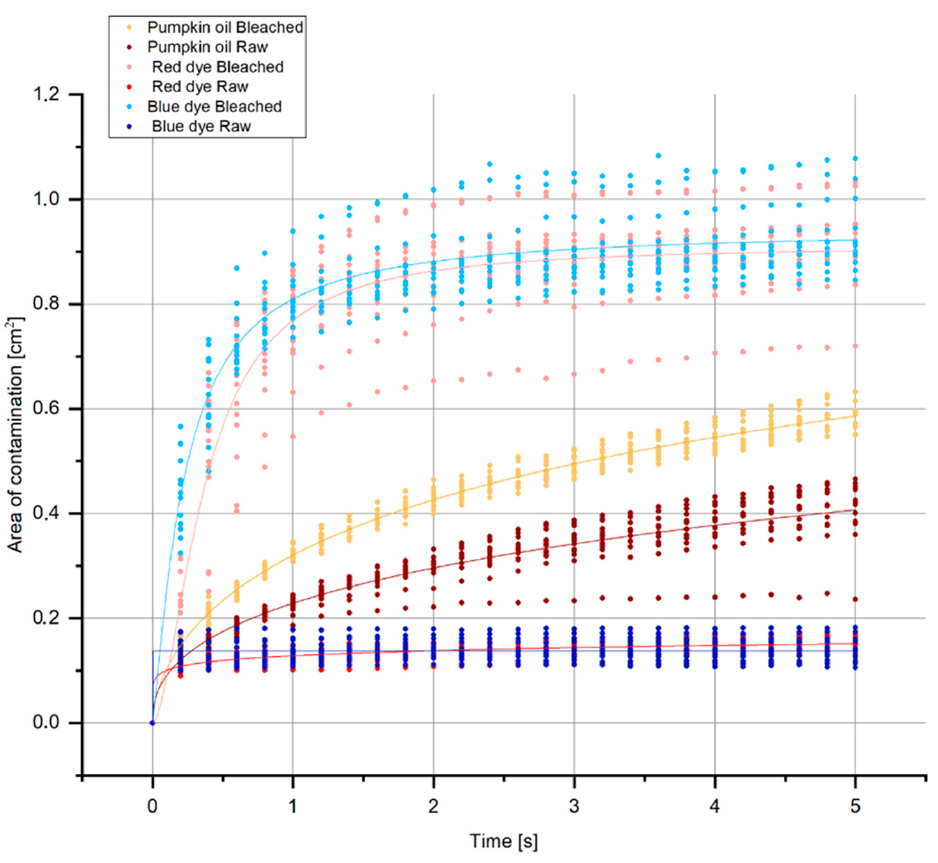
Figure 7. Change in contamination area size (average area size of contamination in cm 2 ) regardless of weave and fabric density in the first 5